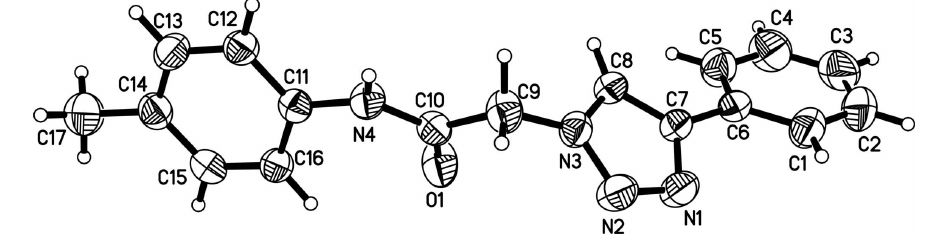
Figure 1 The molecular structure of (I) showing 50% probability displacement ellipsoids and the atom numbering scheme.